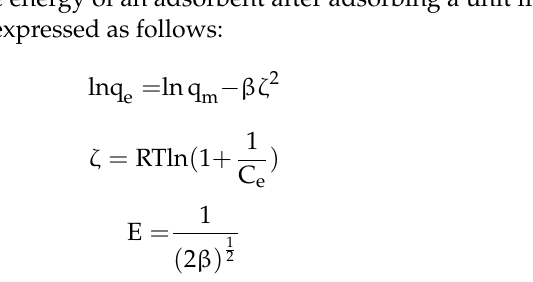
where q e (mol/g) is the quantity of adsorbate adsorbed by the adsorbent, q max (mol/g) is the quantity of maximum adsorption capacity of the adsorbent (mol/g). R (8.314/(mol · K)) is the universal gas constant, T (K) is the absolute solution temperature. β (mol 2 /J 2 ) and ζ (J/mol) are the constants related to adsorption energy and Polanyi adsorption potential, respectively. C e is the equilibrium concentration (mol/L). From the linear plot of lnq e against ζ 2 (Figure 6), both q m and β can be determined. E is the mean free energy of adsorption, which is applied to distinguish the adsorption type. When the magnitude of E is below 8 KJ/mol, the adsorption process is physical adsorption. When the magnitude of E is between 8 and 16 KJ/mol, the adsorption process is ion exchange. When the magnitude of E is above 16 KJ/mol, the adsorption process is chemical